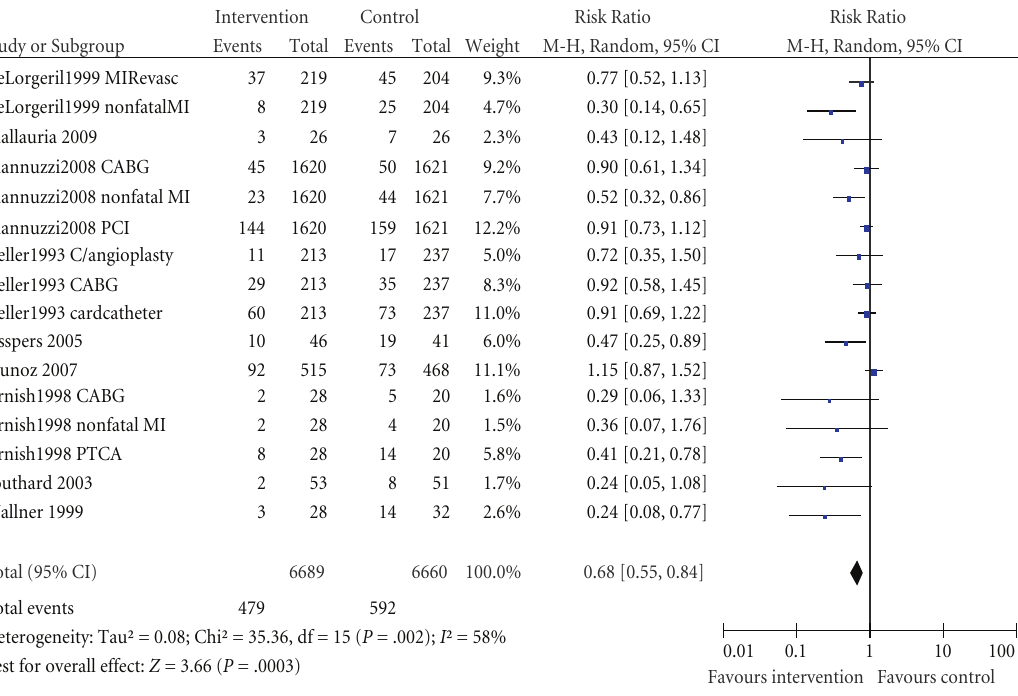
Figure 4: E ff ect of interventions on nonfatal cardiac events: comparison of intervention versus control groups. MIRevasc = elective myocardial revascularisation, CABG = coronary artery bypass graft, PCI = percutaneous coronary intervention, C/angioplasty = coronary angioplasty, Cardcatheter = cardiac catheter, PTCA = percutaneous transluminal coronary